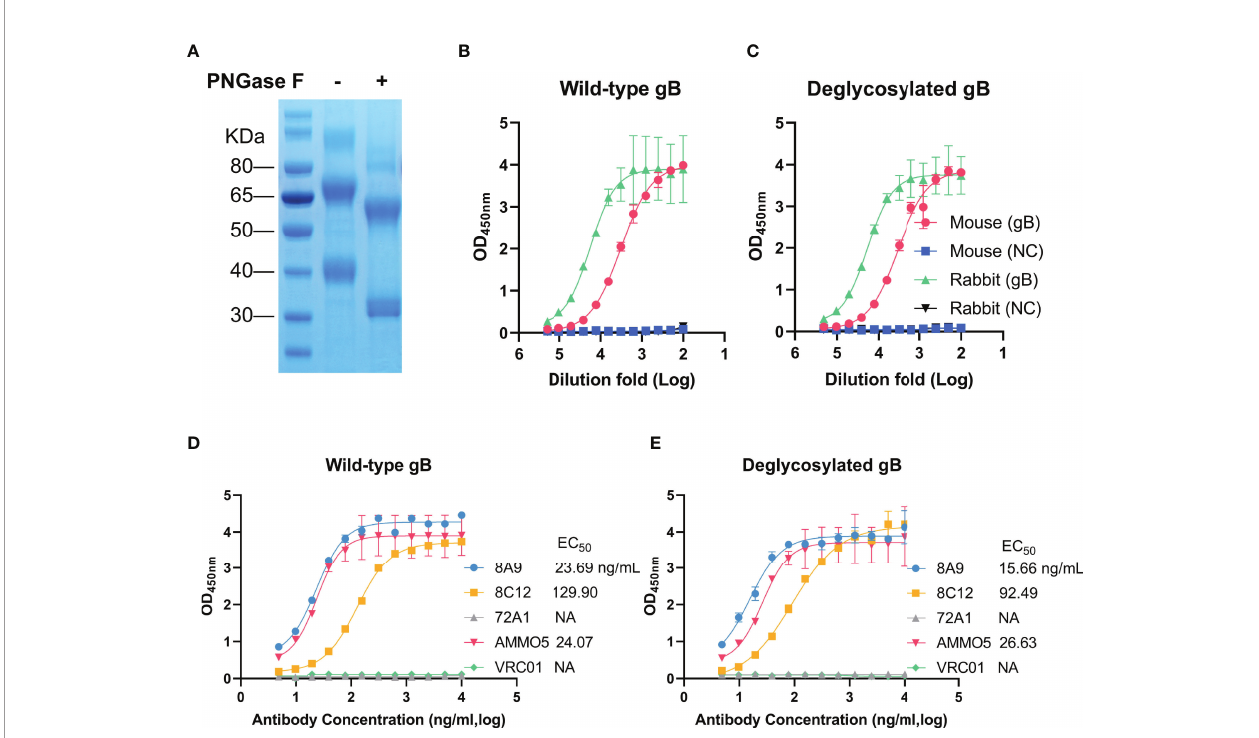
FIGURE 6 | Evaluation of binding abilities with deglycosylated gB of gB NAbs. (A) Wild-type (left) and deglycosylated gB (right) were analyzed by SDS-PAGE. (B, C) Detection of reactivities of gB-immunized sera with (B) wild-type and (C) deglycosylated gB. (D, E) Evaluation of binding activities of MAbs with (D) wild-type and (E) deglycosylated